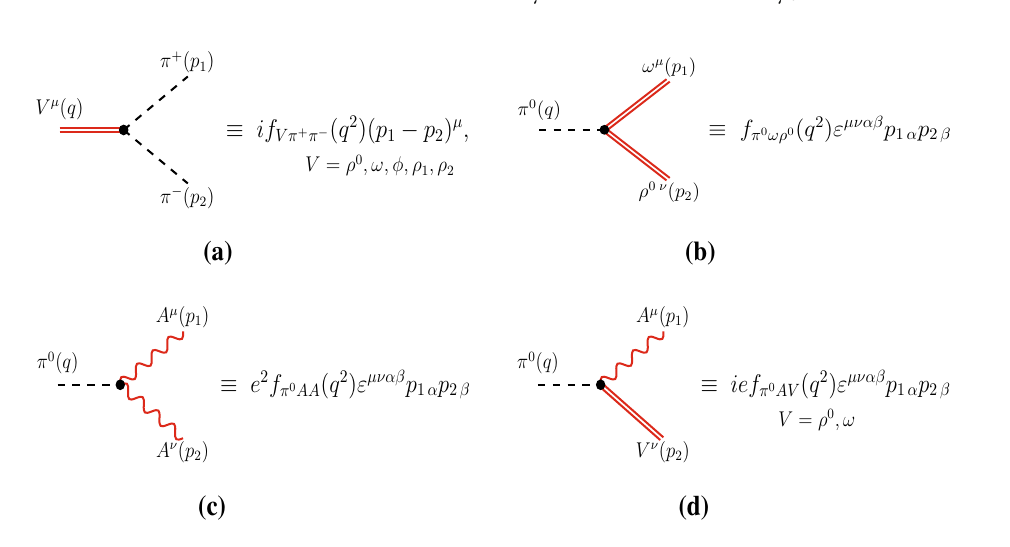
Fig. 7 The γ – V -mixing terms considered in the present work; ρ 1 and ρ ρ( 1450 ) and ρ( 1700 ) , respectively 2 stand for